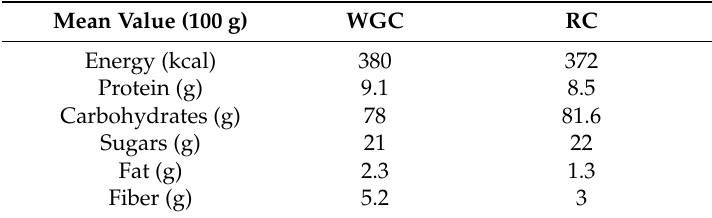
Table 1. Nutritional composition of the two infant cereals used in the